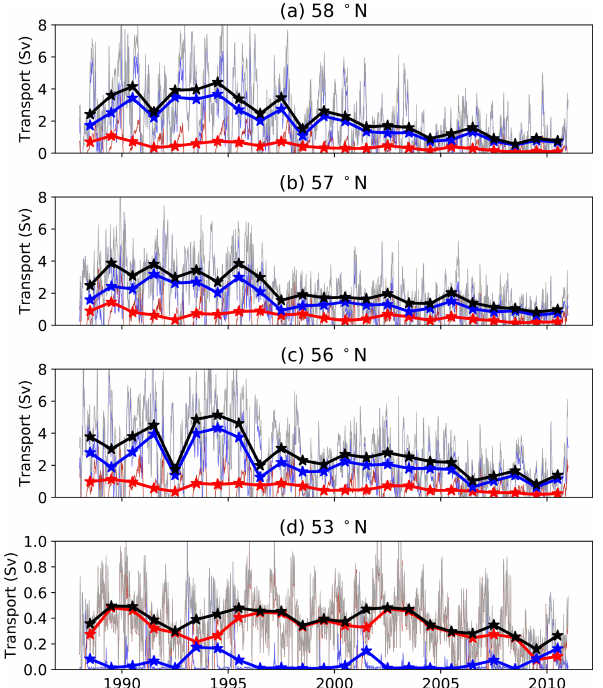
Figure 8. Northward total transport at the shelf edge from the ORCA12 hindcast across zonal transects at (a) 58 ◦ N, (b) 57 ◦ N, (c) 56 ◦ N, and (d) 53 ◦ N (see Fig. 1). Transects are the following length, as constrained by the bathymetry: 53 ◦ N is 53.7km; 56 ◦ N is 51.0km; 57 ◦ N is 50.2km; 58 ◦ N is 49.5km. Total transport is in- dicated with black lines. Transport at temperatures above and below 11 ◦ C is indicated with red and blue lines, respectively. Thin lines show 5d means. Thick lines and stars indicate the annual mean. Note that y -axis scales in (d) are different from (a–c)